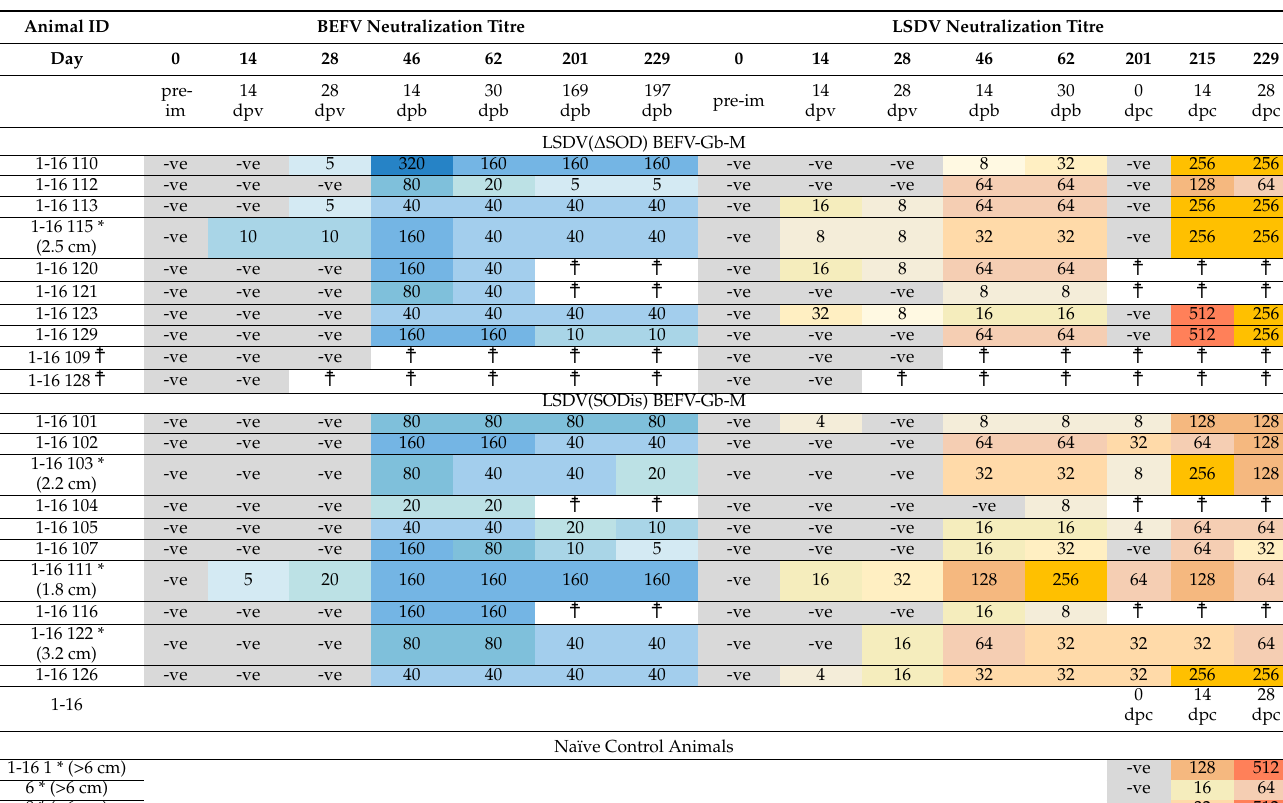
Vaccines 2021 , 9 , x Table 2. Neutralization responses of cattle to BEFV (blue) and LSDV (orange). Titres are expressed as the reciprocal of the Table 2. Neutralization responses of cattle to BEFV (blue) and LSDV (orange). Titres are expressed as the reciprocal of the dilution required to neutralize the virus in 50% or more of wells of cells infected with BEFV or LSDV, respectively. The higher dilution required to neutralize the virus in 50% or more of wells of cells infected with BEFV or LSDV, respectively. The the titre the darker the shade. Titres < 1/5 for BEFV and <1/4 for LSDV were regarded as -ve. pre-im = pre-immunisation, higher the titre the darker the shade. Titres < 1/5 for BEFV and <1/4 for LSDV were regarded as -ve. pre-im = pre- Table 2 shows the neutralizing responses elicited at different time points post Table 2 shows the neutralizing responses elicited at different time points post Table 2 shows the neutralizing responses elicited at different time points post vaccination, post booster vaccination and post LSDV challenge. After one inoculation, vaccination, post booster vaccination and post LSDV challenge. After one inoculation, which developed lesions at sites of inoculation (sizes of lesions in brackets); ☨ animal died (unrelated to vaccination). only 4/20 and 7/20 animals developed neutralizing antibodies against BEFV and LSDV, only 4/20 and 7/20 animals developed neutralizing antibodies against BEFV and LSDV, respectively. Following the boost vaccination, all animals developed neutralizing respectively. Following the boost vaccination, all animals developed neutralizing responses to both BEFV and LSDV. Neutralizing antibodies against BEFV persisted for >6 Table 2 shows the neutralizing responses elicited at different time points post Vaccines 2021 , 9 , x responses to both BEFV and LSDV. Neutralizing antibodies against BEFV persisted for >6 months post boost in all vaccinated animals. All animals vaccinated with vaccination, post booster vaccination and post LSDV challenge. After one inoculation, months post boost in all vaccinated animals. All animals vaccinated with LSDV( ∆ SOD)BEFV-Gb-M lost detectable LSDV neutralizing antibodies by day 201 (169 only 4/20 and 7/20 animals developed neutralizing antibodies against BEFV and LSDV, LSDV( ∆ SOD)BEFV-Gb-M lost detectable LSDV neutralizing antibodies by day 201 (169 LSDV( ∆ SOD)BEFV-Gb-M lost detectable LSDV neutralizing antibodies by day 201 (169 dpb), but 7/8 of the animals vaccinated with LSDV(SODis)BEFV-Gb-M retained LSDV Table 2. Neutralization responses of cattle to BEFV (blue) and LSDV (orange). Titres are expressed as the reciprocal of the Table 2. Neutralization responses of cattle to BEFV (blue) and LSDV (orange). Titres are expressed as the reciprocal of the Table 2. Neutralization responses of cattle to BEFV (blue) and LSDV (orange). Titres are expressed as the reciprocal of the Table 2. Neutralization responses of cattle to BEFV (blue) and LSDV (orange). Titres are expressed as the reciprocal of the Table 2. Neutralization responses of cattle to BEFV (blue) and LSDV (orange). Titres are expressed as the reciprocal of the respectively. Following the boost vaccination, all animals developed neutralizing dpb), but 7/8 of the animals vaccinated with LSDV(SODis)BEFV-Gb-M retained LSDV dpb), but 7/8 of the animals vaccinated with LSDV(SODis)BEFV-Gb-M retained LSDV dpb), but 7/8 of the animals vaccinated with LSDV(SODis)BEFV-Gb-M retained LSDV Table 2. Neutralization responses of cattle to BEFV (blue) and LSDV (orange). Titres are expressed as the reciprocal of the Table 2. Neutralization responses of cattle to BEFV (blue) and LSDV (orange). Titres are expressed as the reciprocal of the Table 2. Neutralization responses of cattle to BEFV (blue) and LSDV (orange). Titres are expressed as the reciprocal of the Table 2. Neutralization responses of cattle to BEFV (blue) and LSDV (orange). Titres are expressed as the reciprocal of the Table 2. Neutralization responses of cattle to BEFV (blue) and LSDV (orange). Titres are expressed as the reciprocal of the Table 2 shows the neutralizing responses elicited at different time points post Table 2 shows the neutralizing responses elicited at different time points post neutralizing antibodies until the time of challenge (169 dpb). dilution required to neutralize the virus in 50% or more of wells of cells infected with BEFV or LSDV, respectively. The dilution required to neutralize the virus in 50% or more of wells of cells infected with BEFV or LSDV, respectively. The dilution required to neutralize the virus in 50% or more of wells of cells infected with BEFV or LSDV, respectively. The dilution required to neutralize the virus in 50% or more of wells of cells infected with BEFV or LSDV, respectively. The dilution required to neutralize the virus in 50% or more of wells of cells infected with BEFV or LSDV, respectively. The responses to both BEFV and LSDV. Neutralizing antibodies against BEFV persisted for >6 neutralizing antibodies until the time of challenge (169 dpb). dilution required to neutralize the virus in 50% or more of wells of cells infected with BEFV or LSDV, respectively. The dilution required to neutralize the virus in 50% or more of wells of cells infected with BEFV or LSDV, respectively. The dilution required to neutralize the virus in 50% or more of wells of cells infected with BEFV or LSDV, respectively. The dilution required to neutralize the virus in 50% or more of wells of cells infected with BEFV or LSDV, respectively. The dilution required to neutralize the virus in 50% or more of wells of cells infected with BEFV or LSDV, respectively. The vaccination, post booster vaccination and post LSDV challenge. After one inoculation, vaccination, post booster vaccination and post LSDV challenge. After one inoculation, higher the titre the darker the shade. Titres < 1/5 for BEFV and <1/4 for LSDV were regarded as -ve. pre-im = pre- higher the titre the darker the shade. Titres < 1/5 for BEFV and <1/4 for LSDV were regarded as -ve. pre-im = pre- higher the titre the darker the shade. Titres < 1/5 for BEFV and <1/4 for LSDV were regarded as -ve. pre-im = pre- higher the titre the darker the shade. Titres < 1/5 for BEFV and <1/4 for LSDV were regarded as -ve. pre-im = pre- higher the titre the darker the shade. Titres < 1/5 for BEFV and <1/4 for LSDV were regarded as -ve. pre-im = pre- months post boost in all vaccinated animals. All animals vaccinated with higher the titre the darker the shade. Titres < 1/5 for BEFV and <1/4 for LSDV were regarded as -ve. pre-im = pre- higher the titre the darker the shade. Titres < 1/5 for BEFV and <1/4 for LSDV were regarded as -ve. pre-im = pre- higher the titre the darker the shade. Titres < 1/5 for BEFV and <1/4 for LSDV were regarded as -ve. pre-im = pre- higher the titre the darker the shade. Titres < 1/5 for BEFV and <1/4 for LSDV were regarded as -ve. pre-im = pre- higher the titre the darker the shade. Titres < 1/5 for BEFV and <1/4 for LSDV were regarded as -ve. pre-im = pre- immunisation, dpv = days post vaccination, dpb = days post boost, dpc = days post challenge; asterisks show animals immunisation, dpv = days post vaccination, dpb = days post boost, dpc = days post challenge; asterisks show animals immunisation, dpv = days post vaccination, dpb = days post boost, dpc = days post challenge; asterisks show animals Table 2. Neutralization responses of cattle to BEFV (blue) and LSDV (orange). Titres are expressed as the reciprocal of the Table 2. Neutralization responses of cattle to BEFV (blue) and LSDV (orange). Titres are expressed as the reciprocal of the Table 2. Neutralization responses of cattle to BEFV (blue) and LSDV (orange). Titres are expressed as the reciprocal of the Table 2. Neutralization responses of cattle to BEFV (blue) and LSDV (orange). Titres are expressed as the reciprocal of the Table 2. Neutralization responses of cattle to BEFV (blue) and LSDV (orange). Titres are expressed as the reciprocal of the Table 2. Neutralization responses of cattle to BEFV (blue) and LSDV (orange). Titres are expressed as the reciprocal of the Table 2. Neutralization responses of cattle to BEFV (blue) and LSDV (orange). Titres are expressed as the reciprocal of the Table 2. Neutralization responses of cattle to BEFV (blue) and LSDV (orange). Titres are expressed as the reciprocal of the Table 2. Neutralization responses of cattle to BEFV (blue) and LSDV (orange). Titres are expressed as the reciprocal of the Table 2. Neutralization responses of cattle to BEFV (blue) and LSDV (orange). Titres are expressed as the reciprocal of the only 4/20 and 7/20 animals developed neutralizing antibodies against BEFV and LSDV, only 4/20 and 7/20 animals developed neutralizing antibodies against BEFV and LSDV, immunisation, dpv = days post vaccination, dpb = days post boost, dpc = days post challenge; asterisks show animals immunisation, dpv = days post vaccination, dpb = days post boost, dpc = days post challenge; asterisks show animals immunisation, dpv = days post vaccination, dpb = days post boost, dpc = days post challenge; asterisks show animals immunisation, dpv = days post vaccination, dpb = days post boost, dpc = days post challenge; asterisks show animals Table 2. Neutralization responses of cattle to BEFV (blue) and LSDV (orange). Titres are expressed as the reciprocal of the Table 2. Neutralization responses of cattle to BEFV (blue) and LSDV (orange). Titres are expressed as the reciprocal of the Table 2. Neutralization responses of cattle to BEFV (blue) and LSDV (orange). Titres are expressed as the reciprocal of the Table 2. Neutralization responses of cattle to BEFV (blue) and LSDV (orange). Titres are expressed as the reciprocal of the Table 2. Neutralization responses of cattle to BEFV (blue) and LSDV (orange). Titres are expressed as the reciprocal of the Table 2. Neutralization responses of cattle to BEFV (blue) and LSDV (orange). Titres are expressed as the reciprocal of the Table 2. Neutralization responses of cattle to BEFV (blue) and LSDV (orange). Titres are expressed as the reciprocal of the Table 2. Neutralization responses of cattle to BEFV (blue) and LSDV (orange). Titres are expressed as the reciprocal of the Table 2. Neutralization responses of cattle to BEFV (blue) and LSDV (orange). Titres are expressed as the reciprocal of the Table 2. Neutralization responses of cattle to BEFV (blue) and LSDV (orange). Titres are expressed as the reciprocal of the Table 2. Neutralization responses of cattle to BEFV (blue) and LSDV (orange). Titres are expressed as the reciprocal of the Table 2. Neutralization responses of cattle to BEFV (blue) and LSDV (orange). Titres are expressed as the reciprocal of the which developed lesions at sites of inoculation (sizes of lesions in brackets); ☨ animal died (unrelated to vaccination). which developed lesions at sites of inoculation (sizes of lesions in brackets); ☨ animal died (unrelated to vaccination). which developed lesions at sites of inoculation (sizes of lesions in brackets); ☨ animal died (unrelated to vaccination). which developed lesions at sites of inoculation (sizes of lesions in brackets); ☨ animal died (unrelated to vaccination). which developed lesions at sites of inoculation (sizes of lesions in brackets); ☨ animal died (unrelated to vaccination). dilution required to neutralize the virus in 50% or more of wells of cells infected with BEFV or LSDV, respectively. The dilution required to neutralize the virus in 50% or more of wells of cells infected with BEFV or LSDV, respectively. The dilution required to neutralize the virus in 50% or more of wells of cells infected with BEFV or LSDV, respectively. The dilution required to neutralize the virus in 50% or more of wells of cells infected with BEFV or LSDV, respectively. The dilution required to neutralize the virus in 50% or more of wells of cells infected with BEFV or LSDV, respectively. The dilution required to neutralize the virus in 50% or more of wells of cells infected with BEFV or LSDV, respectively. The dilution required to neutralize the virus in 50% or more of wells of cells infected with BEFV or LSDV, respectively. The dilution required to neutralize the virus in 50% or more of wells of cells infected with BEFV or LSDV, respectively. The dilution required to neutralize the virus in 50% or more of wells of cells infected with BEFV or LSDV, respectively. The dilution required to neutralize the virus in 50% or more of wells of cells infected with BEFV or LSDV, respectively. The respectively. Following the boost vaccination, all animals developed neutralizing respectively. Following the boost vaccination, all animals developed neutralizing which developed lesions at sites of inoculation (sizes of lesions in brackets); ☨ animal died (unrelated to vaccination). which developed lesions at sites of inoculation (sizes of lesions in brackets); ☨ animal died (unrelated to vaccination). which developed lesions at sites of inoculation (sizes of lesions in brackets); ☨ animal died (unrelated to vaccination). which developed lesions at sites of inoculation (sizes of lesions in brackets); ☨ animal died (unrelated to vaccination). which developed lesions at sites of inoculation (sizes of lesions in brackets); ☨ animal died (unrelated to vaccination). dilution required to neutralize the virus in 50% or more of wells of cells infected with BEFV or LSDV, respectively. The dilution required to neutralize the virus in 50% or more of wells of cells infected with BEFV or LSDV, respectively. The dilution required to neutralize the virus in 50% or more of wells of cells infected with BEFV or LSDV, respectively. The dilution required to neutralize the virus in 50% or more of wells of cells infected with BEFV or LSDV, respectively. The dilution required to neutralize the virus in 50% or more of wells of cells infected with BEFV or LSDV, respectively. The dilution required to neutralize the virus in 50% or more of wells of cells infected with BEFV or LSDV, respectively. The dilution required to neutralize the virus in 50% or more of wells of cells infected with BEFV or LSDV, respectively. The dilution required to neutralize the virus in 50% or more of wells of cells infected with BEFV or LSDV, respectively. The dilution required to neutralize the virus in 50% or more of wells of cells infected with BEFV or LSDV, respectively. The dilution required to neutralize the virus in 50% or more of wells of cells infected with BEFV or LSDV, respectively. The dilution required to neutralize the virus in 50% or more of wells of cells infected with BEFV or LSDV, respectively. The dilution required to neutralize the virus in 50% or more of wells of cells infected with BEFV or LSDV, respectively. The dpb), but 7/8 of the animals vaccinated with LSDV(SODis)BEFV-Gb-M retained LSDV higher the titre the darker the shade. Titres < 1/5 for BEFV and <1/4 for LSDV were regarded as -ve. pre-im = pre- higher the titre the darker the shade. Titres < 1/5 for BEFV and <1/4 for LSDV were regarded as -ve. pre-im = pre- higher the titre the darker the shade. Titres < 1/5 for BEFV and <1/4 for LSDV were regarded as -ve. pre-im = pre- higher the titre the darker the shade. Titres < 1/5 for BEFV and <1/4 for LSDV were regarded as -ve. pre-im = pre- higher the titre the darker the shade. Titres < 1/5 for BEFV and <1/4 for LSDV were regarded as -ve. pre-im = pre- higher the titre the darker the shade. Titres < 1/5 for BEFV and <1/4 for LSDV were regarded as -ve. pre-im = pre- higher the titre the darker the shade. Titres < 1/5 for BEFV and <1/4 for LSDV were regarded as -ve. pre-im = pre- higher the titre the darker the shade. Titres < 1/5 for BEFV and <1/4 for LSDV were regarded as -ve. pre-im = pre- higher the titre the darker the shade. Titres < 1/5 for BEFV and <1/4 for LSDV were regarded as -ve. pre-im = pre- higher the titre the darker the shade. Titres < 1/5 for BEFV and <1/4 for LSDV were regarded as -ve. pre-im = pre- responses to both BEFV and LSDV. Neutralizing antibodies against BEFV persisted for >6 responses to both BEFV and LSDV. Neutralizing antibodies against BEFV persisted for >6 BEFV Neutralization Titre higher the titre the darker the shade. Titres < 1/5 for BEFV and <1/4 for LSDV were regarded as -ve. pre-im = pre- higher the titre the darker the shade. Titres < 1/5 for BEFV and <1/4 for LSDV were regarded as -ve. pre-im = pre- higher the titre the darker the shade. Titres < 1/5 for BEFV and <1/4 for LSDV were regarded as -ve. pre-im = pre- higher the titre the darker the shade. Titres < 1/5 for BEFV and <1/4 for LSDV were regarded as -ve. pre-im = pre- higher the titre the darker the shade. Titres < 1/5 for BEFV and <1/4 for LSDV were regarded as -ve. pre-im = pre- higher the titre the darker the shade. Titres < 1/5 for BEFV and <1/4 for LSDV were regarded as -ve. pre-im = pre- higher the titre the darker the shade. Titres < 1/5 for BEFV and <1/4 for LSDV were regarded as -ve. pre-im = pre- higher the titre the darker the shade. Titres < 1/5 for BEFV and <1/4 for LSDV were regarded as -ve. pre-im = pre- higher the titre the darker the shade. Titres < 1/5 for BEFV and <1/4 for LSDV were regarded as -ve. pre-im = pre- higher the titre the darker the shade. Titres < 1/5 for BEFV and <1/4 for LSDV were regarded as -ve. pre-im = pre- higher the titre the darker the shade. Titres < 1/5 for BEFV and <1/4 for LSDV were regarded as -ve. pre-im = pre- higher the titre the darker the shade. Titres < 1/5 for BEFV and <1/4 for LSDV were regarded as -ve. pre-im = pre- immunisation, dpv = days post vaccination, dpb = days post boost, dpc = days post challenge; asterisks show animals immunisation, dpv = days post vaccination, dpb = days post boost, dpc = days post challenge; asterisks show animals immunisation, dpv = days post vaccination, dpb = days post boost, dpc = days post challenge; asterisks show animals immunisation, dpv = days post vaccination, dpb = days post boost, dpc = days post challenge; asterisks show animals immunisation, dpv = days post vaccination, dpb = days post boost, dpc = days post challenge; asterisks show animals immunisation, dpv = days post vaccination, dpb = days post boost, dpc = days post challenge; asterisks show animals immunisation, dpv = days post vaccination, dpb = days post boost, dpc = days post challenge; asterisks show animals neutralizing antibodies until the time of challenge (169 dpb). months post boost in all vaccinated animals. All animals vaccinated with months post boost in all vaccinated animals. All animals vaccinated with Animal ID Animal ID immunisation, dpv = days post vaccination, dpb = days post boost, dpc = days post challenge; asterisks show animals immunisation, dpv = days post vaccination, dpb = days post boost, dpc = days post challenge; asterisks show animals immunisation, dpv = days post vaccination, dpb = days post boost, dpc = days post challenge; asterisks show animals immunisation, dpv = days post vaccination, dpb = days post boost, dpc = days post challenge; asterisks show animals immunisation, dpv = days post vaccination, dpb = days post boost, dpc = days post challenge; asterisks show animals immunisation, dpv = days post vaccination, dpb = days post boost, dpc = days post challenge; asterisks show animals immunisation, dpv = days post vaccination, dpb = days post boost, dpc = days post challenge; asterisks show animals immunisation, dpv = days post vaccination, dpb = days post boost, dpc = days post challenge; asterisks show animals which developed lesions at sites of inoculation (sizes of lesions in brackets); ☨ animal died (unrelated to vaccination). which developed lesions at sites of inoculation (sizes of lesions in brackets); ☨ animal died (unrelated to vaccination). which developed lesions at sites of inoculation (sizes of lesions in brackets); ☨ animal died (unrelated to vaccination). which developed lesions at sites of inoculation (sizes of lesions in brackets); ☨ animal died (unrelated to vaccination). which developed lesions at sites of inoculation (sizes of lesions in brackets); ☨ animal died (unrelated to vaccination). which developed lesions at sites of inoculation (sizes of lesions in brackets); ☨ animal died (unrelated to vaccination). which developed lesions at sites of inoculation (sizes of lesions in brackets); ☨ animal died (unrelated to vaccination). which developed lesions at sites of inoculation (sizes of lesions in brackets); ☨ animal died (unrelated to vaccination). which developed lesions at sites of inoculation (sizes of lesions in brackets); ☨ animal died (unrelated to vaccination). which developed lesions at sites of inoculation (sizes of lesions in brackets); ☨ animal died (unrelated to vaccination). LSDV( ∆ SOD)BEFV-Gb-M lost detectable LSDV neutralizing antibodies by day 201 (169 LSDV( ∆ SOD)BEFV-Gb-M lost detectable LSDV neutralizing antibodies by day 201 (169 which developed lesions at sites of inoculation (sizes of lesions in brackets); ☨ animal died (unrelated to vaccination). which developed lesions at sites of inoculation (sizes of lesions in brackets); ☨ animal died (unrelated to vaccination). which developed lesions at sites of inoculation (sizes of lesions in brackets); ☨ animal died (unrelated to vaccination). which developed lesions at sites of inoculation (sizes of lesions in brackets); ☨ animal died (unrelated to vaccination). which developed lesions at sites of inoculation (sizes of lesions in brackets); ☨ animal died (unrelated to vaccination). which developed lesions at sites of inoculation (sizes of lesions in brackets); ☨ animal died (unrelated to vaccination). which developed lesions at sites of inoculation (sizes of lesions in brackets); ☨ animal died (unrelated to vaccination). which developed lesions at sites of inoculation (sizes of lesions in brackets); ☨ animal died (unrelated to vaccination). which developed lesions at sites of inoculation (sizes of lesions in brackets); ☨ animal died (unrelated to vaccination). which developed lesions at sites of inoculation (sizes of lesions in brackets); ☨ animal died (unrelated to vaccination). Table 2. Neutralization responses of cattle to BEFV (blue) and LSDV (orange). Titres are expressed as the reciprocal of the Table 2. Neutralization responses of cattle to BEFV (blue) and LSDV (orange). Titres are expressed as the reciprocal of the Table 2. Neutralization responses of cattle to BEFV (blue) and LSDV (orange). Titres are expressed as the reciprocal of the Table 2. Neutralization responses of cattle to BEFV (blue) and LSDV (orange). Titres are expressed as the reciprocal of the Table 2. Neutralization responses of cattle to BEFV (blue) and LSDV (orange). Titres are expressed as the reciprocal of the dpb), but 7/8 of the animals vaccinated with LSDV(SODis)BEFV-Gb-M retained LSDV dpb), but 7/8 of the animals vaccinated with LSDV(SODis)BEFV-Gb-M retained LSDV Animal ID BEFV Neutralization Titre Animal ID dilution required to neutralize the virus in 50% or more of wells of cells infected with BEFV or LSDV, respectively. The dilution required to neutralize the virus in 50% or more of wells of cells infected with BEFV or LSDV, respectively. The dilution required to neutralize the virus in 50% or more of wells of cells infected with BEFV or LSDV, respectively. The dilution required to neutralize the virus in 50% or more of wells of cells infected with BEFV or LSDV, respectively. The dilution required to neutralize the virus in 50% or more of wells of cells infected with BEFV or LSDV, respectively. The Animal ID BEFV Neutralization Titre Animal ID BEFV Neutralization Titre Animal ID BEFV Neutralization Titre neutralizing antibodies until the time of challenge (169 dpb). neutralizing antibodies until the time of challenge (169 dpb). higher the titre the darker the shade. Titres < 1/5 for BEFV and <1/4 for LSDV were regarded as -ve. pre-im = pre- higher the titre the darker the shade. Titres < 1/5 for BEFV and <1/4 for LSDV were regarded as -ve. pre-im = pre- higher the titre the darker the shade. Titres < 1/5 for BEFV and <1/4 for LSDV were regarded as -ve. pre-im = pre- higher the titre the darker the shade. Titres < 1/5 for BEFV and <1/4 for LSDV were regarded as -ve. pre-im = pre- higher the titre the darker the shade. Titres < 1/5 for BEFV and <1/4 for LSDV were regarded as -ve. pre-im = pre- immunisation, dpv = days post vaccination, dpb = days post boost, dpc = days post challenge; asterisks show animals immunisation, dpv = days post vaccination, dpb = days post boost, dpc = days post challenge; asterisks show animals Table 2. Neutralization responses of cattle to BEFV (blue) and LSDV (orange). Titres are expressed as the reciprocal of the Table 2. Neutralization responses of cattle to BEFV (blue) and LSDV (orange). Titres are expressed as the reciprocal of the Table 2. Neutralization responses of cattle to BEFV (blue) and LSDV (orange). Titres are expressed as the reciprocal of the Table 2. Neutralization responses of cattle to BEFV (blue) and LSDV (orange). Titres are expressed as the reciprocal of the Table 2. Neutralization responses of cattle to BEFV (blue) and LSDV (orange). Titres are expressed as the reciprocal of the which developed lesions at sites of inoculation (sizes of lesions in brackets); ☨ animal died (unrelated to vaccination). which developed lesions at sites of inoculation (sizes of lesions in brackets); ☨ animal died (unrelated to vaccination). which developed lesions at sites of inoculation (sizes of lesions in brackets); ☨ animal died (unrelated to vaccination). dilution required to neutralize the virus in 50% or more of wells of cells infected with BEFV or LSDV, respectively. The dilution required to neutralize the virus in 50% or more of wells of cells infected with BEFV or LSDV, respectively. The dilution required to neutralize the virus in 50% or more of wells of cells infected with BEFV or LSDV, respectively. The dilution required to neutralize the virus in 50% or more of wells of cells infected with BEFV or LSDV, respectively. The dilution required to neutralize the virus in 50% or more of wells of cells infected with BEFV or LSDV, respectively. The higher the titre the darker the shade. Titres < 1/5 for BEFV and <1/4 for LSDV were regarded as -ve. pre-im = pre- higher the titre the darker the shade. Titres < 1/5 for BEFV and <1/4 for LSDV were regarded as -ve. pre-im = pre- higher the titre the darker the shade. Titres < 1/5 for BEFV and <1/4 for LSDV were regarded as -ve. pre-im = pre- higher the titre the darker the shade. Titres < 1/5 for BEFV and <1/4 for LSDV were regarded as -ve. pre-im = pre- higher the titre the darker the shade. Titres < 1/5 for BEFV and <1/4 for LSDV were regarded as -ve. pre-im = pre- Animal ID BEFV Neutralization Titre immunisation, dpv = days post vaccination, dpb = days post boost, dpc = days post challenge; asterisks show animals immunisation, dpv = days post vaccination, dpb = days post boost, dpc = days post challenge; asterisks show animals immunisation, dpv = days post vaccination, dpb = days post boost, dpc = days post challenge; asterisks show animals immunisation, dpv = days post vaccination, dpb = days post boost, dpc = days post challenge; asterisks show animals which developed lesions at sites of inoculation (sizes of lesions in brackets); ☨ animal died (unrelated to vaccination). which developed lesions at sites of inoculation (sizes of lesions in brackets); ☨ animal died (unrelated to vaccination). which developed lesions at sites of inoculation (sizes of lesions in brackets); ☨ animal died (unrelated to vaccination). which developed lesions at sites of inoculation (sizes of lesions in brackets); ☨ animal died (unrelated to vaccination). BEFV Neutralization Titre Animal ID BEFV Neutralization Titre LSDV Neutralization Titre Animal